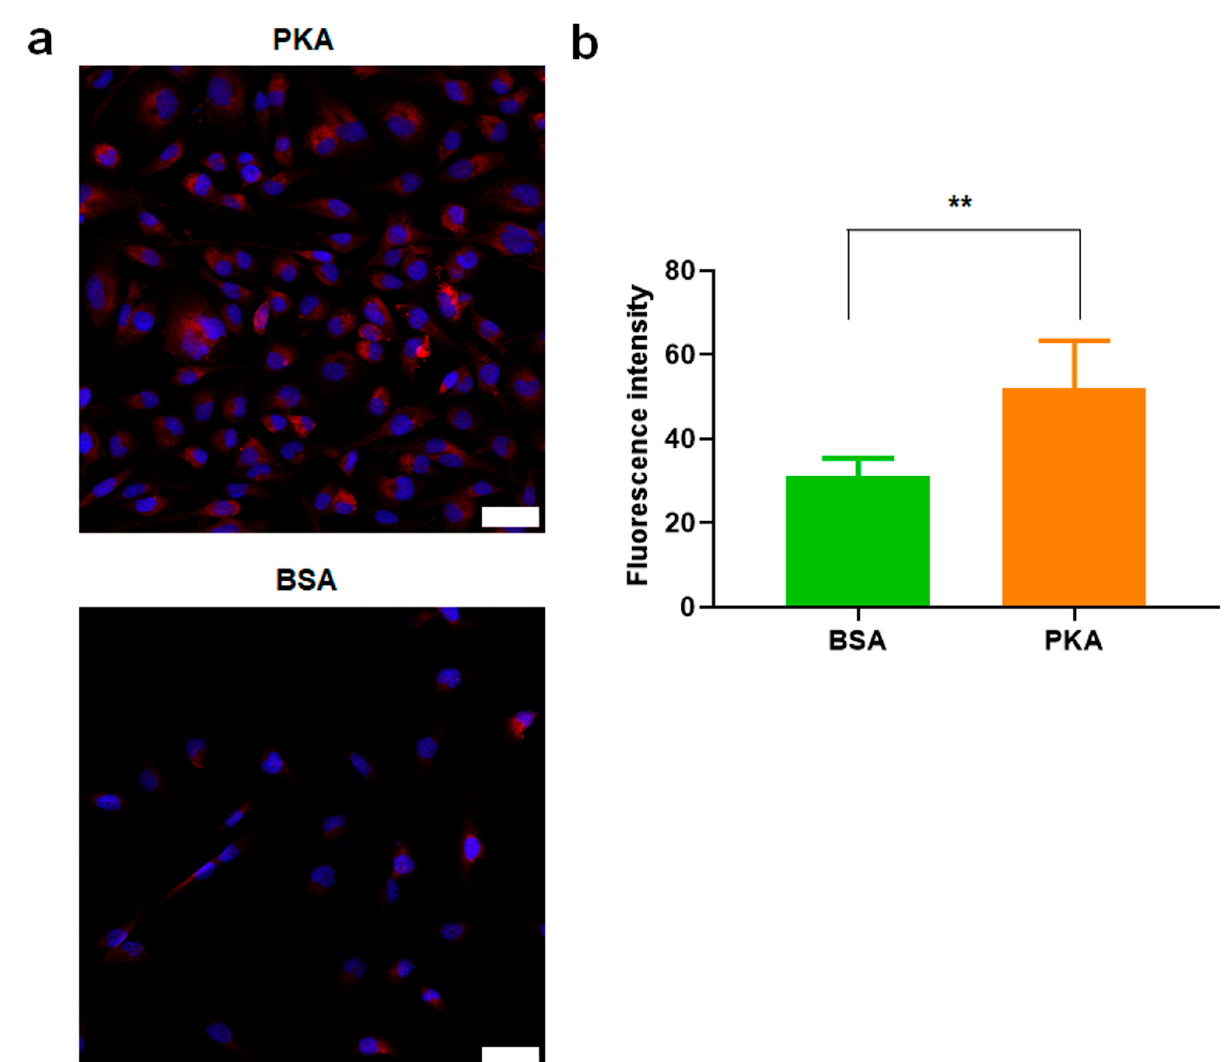
Figure 3. Immunofluorescence analysis of PKA expression in BT-549 cells after CRISPRMAX-based PKA delivery. ( a ) PKA expression was examined by immunofluorescence analysis using CLSM; 3 days after CRISPRMAX-based PKA delivery vs. CRISPRMAX-based BSA delivery (control) in BT-549 cells. Cell nuclei were visualized by DAPI. Confocal images were taken at 200 × magnification (scale bars, 50 µ m). ( b ) Quantitative analysis of the mean of florescence intensity of PKA performed by ImageJ ( n = 3), and the mean of fluorescence intensity of PKA was significantly higher compared with BSA group, p = 0.00459, ** p < 0.01. The quantitative data were presented as Mean ± SD.